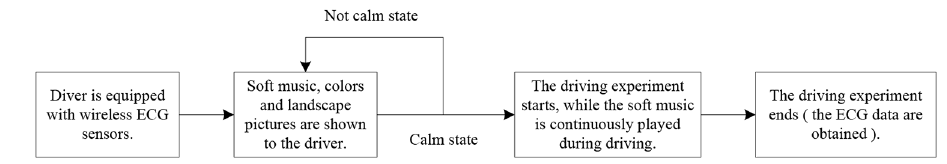
Figure 8 The experimental process of real driving and driving simulations in calm